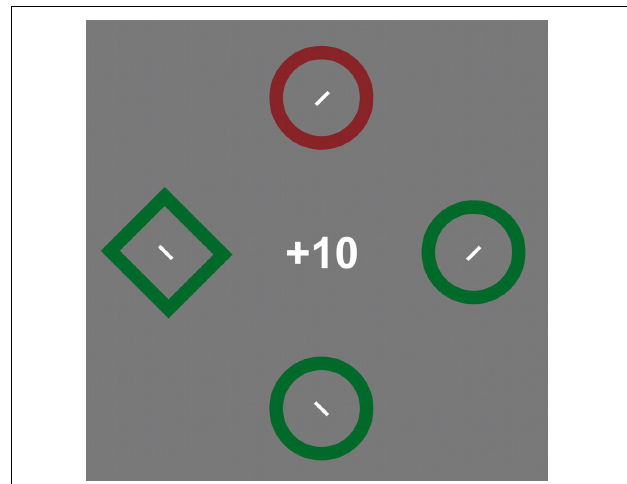
FIGURE 4 | An illustration of the stimuli used in experiment 4. Observers were to locate the target with the odd shape (the green diamond) and report the tilt of the line inside it. The example in the figure shows a trial with an irrelevant singleton (the red circle). Stimuli are not drawn to scale (see Method for details).